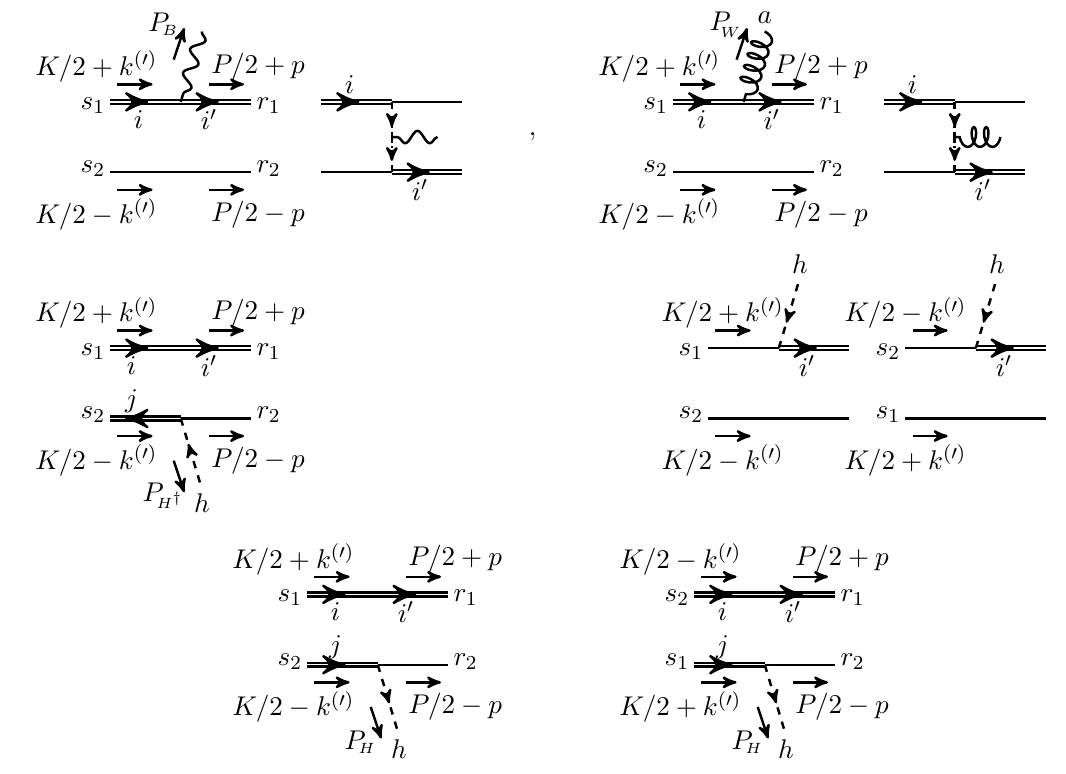
Figure 8 . Same as figure 5, for the formation of DS bound states. Top row: DS → B ( DS ) + B (left) and DS → B ( DS )+ W (right). Middle row: D ¯ D -like → B ( DS )+ H † and SS -like → B ( DS )+ ¯ H † . The diagram on the left gives also D D → B ( DS ) + H † . Bottom row: DD → B ( DS ) + H